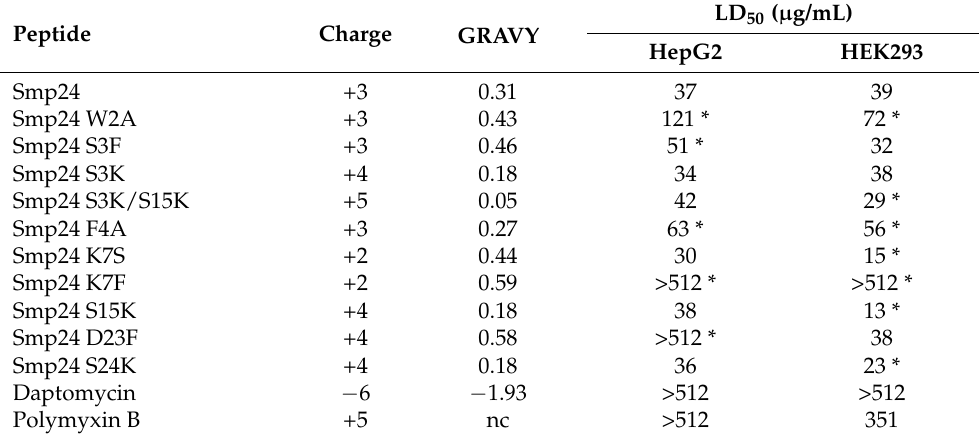
Figure 1. Therapeutic indices of Smp24 and derived modifications. TI calculations of peptides against HepG2 ( A ), HEK293 ( B ), sheep erythrocytes ( C ), daptomycin against all cell lines ( D ) and polymyxin B against all cell lines ( E ). TIs of AMPs and PMB were calculated against E. coli . As daptomycin is only effective against Gram-positive isolates, its TI was calculated against S. aureus. Statistical significance of the difference between Smp24 and its derivatives was determined by performing a T -test on TI data and denoted by * equal to p -value < 0.05, ** p -value < 0.01, *** p -value < 0.001 and **** p -value < 0.0001. Table 4. Cytotoxicity profiles of Smp24 and its derivatives against human kidney (HEK293) and liver (HepG2) cells. Statistically significant increases or decreases in cytotoxic profile between Smp24 and its derivatives are labelled * denotes p -value < 0.05. nc denotes not calculable due to the mixed population of the two separate